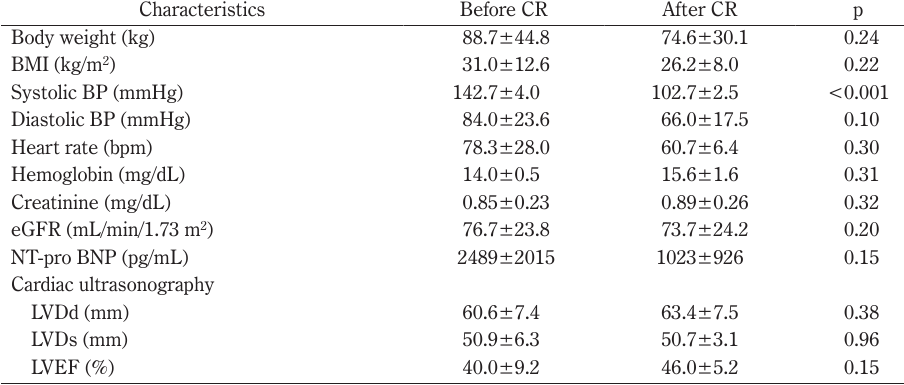
Table 2 Characteristics of the three selected patients with heart failure before and after